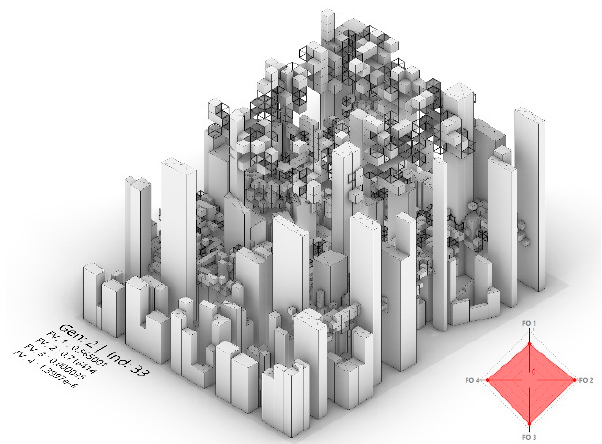
Figure 19. The solution with equal weighting for all fitness functions. Although this solution minimises trade-offs between fitness functions, its performance is significantly poor when compared to the other selected solutions.